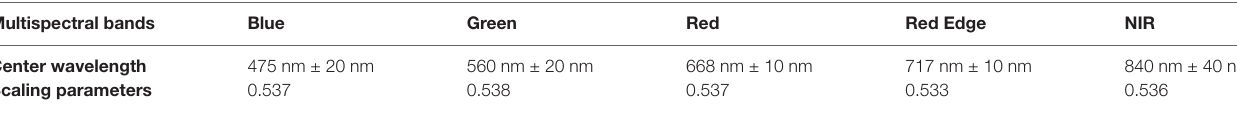
TABLE 1 | Red Edge-MX multispectral sensor and calibration parameter settings. Multispectral